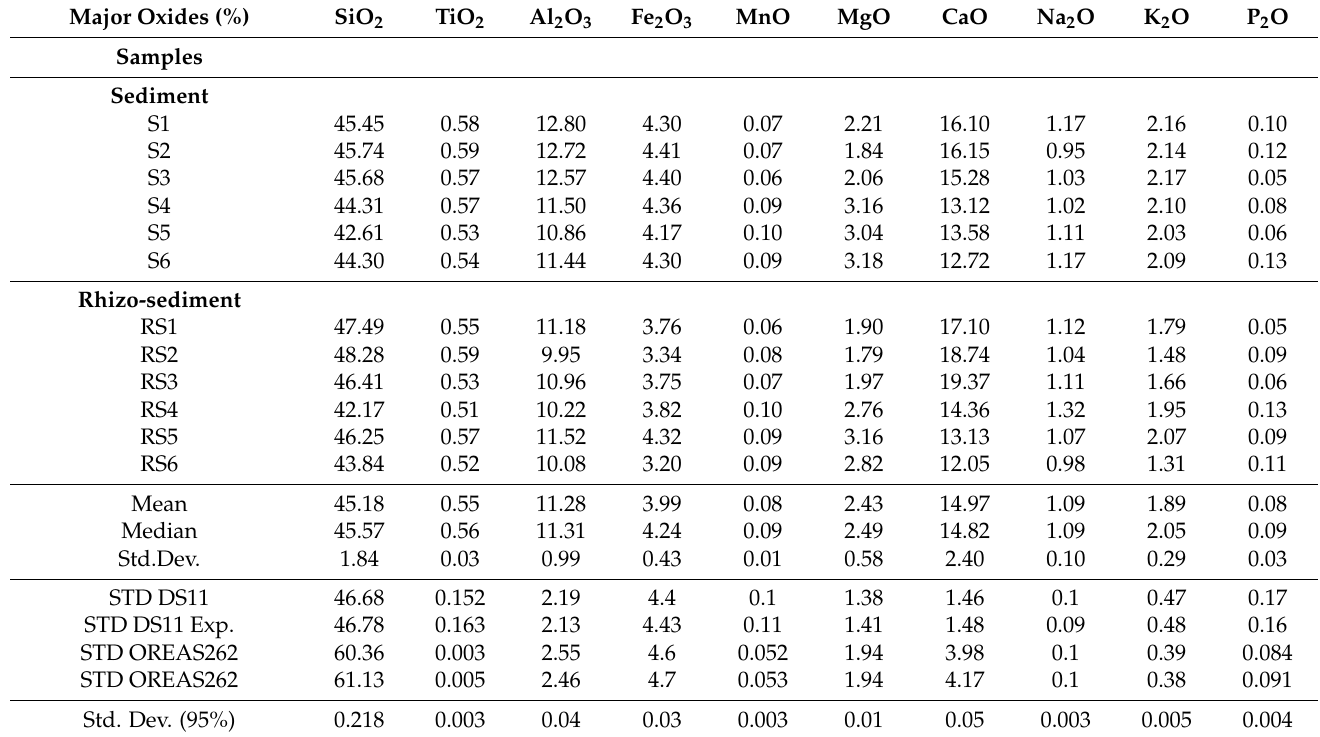
Table 4. Major chemical composition of sediment samples (in %), including mean, standard deviation, minimum and maximum values, and standards data.